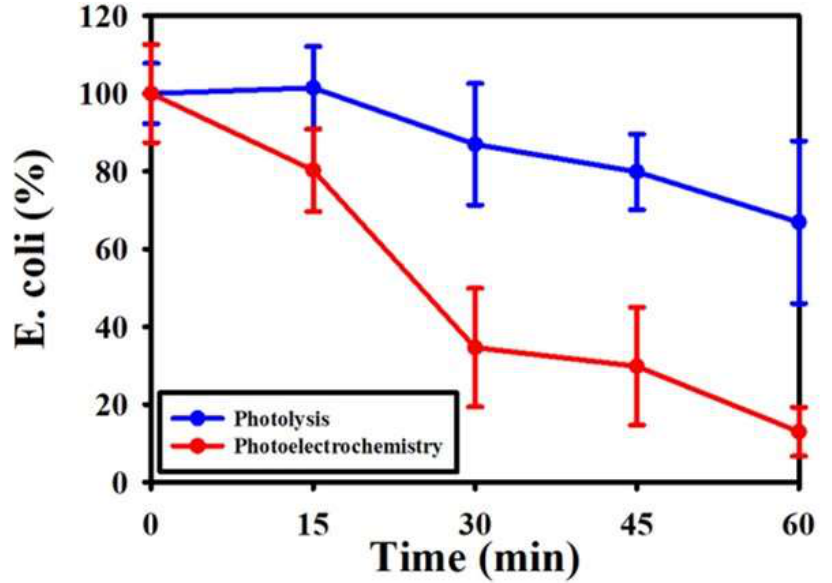
Figure 9. PEC and P removal of E. coli (light source: 100 W hg lamp, applied potential: +1.0 V (vs. Ag/AgCl), electrolyte: E. coli in 0.1 M NaCl solution, reference electrode: Ag/AgCl, counter electrode: Pt wire, and working electrode: Fe/TNAs-0.5).